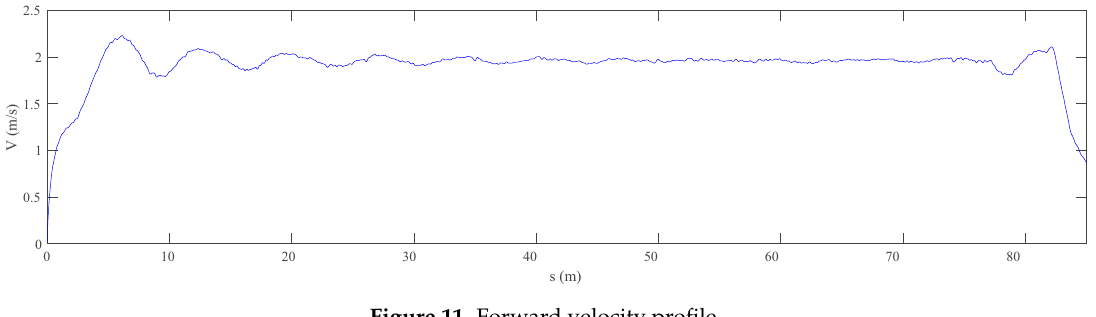
Figure 11. Forward velocity